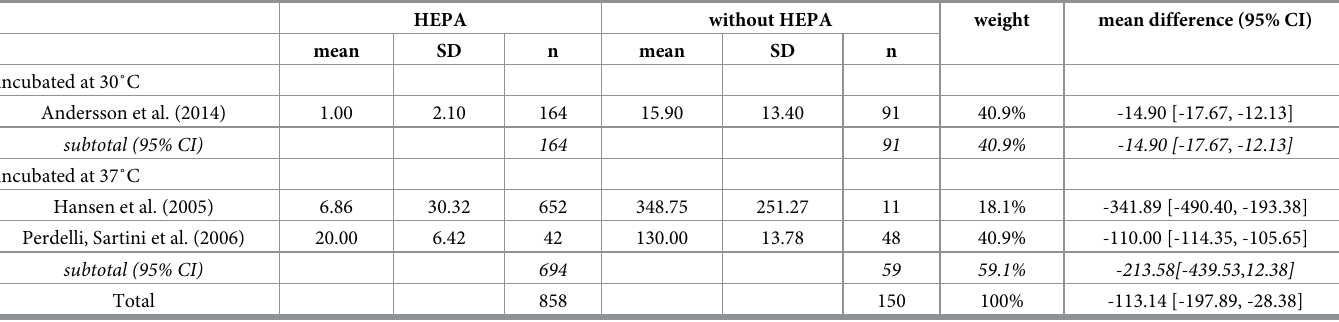
Test for heterogeneity showed very high inconsistency between the studies (I 2 = 99.8%). Test for publication bias p = 1.